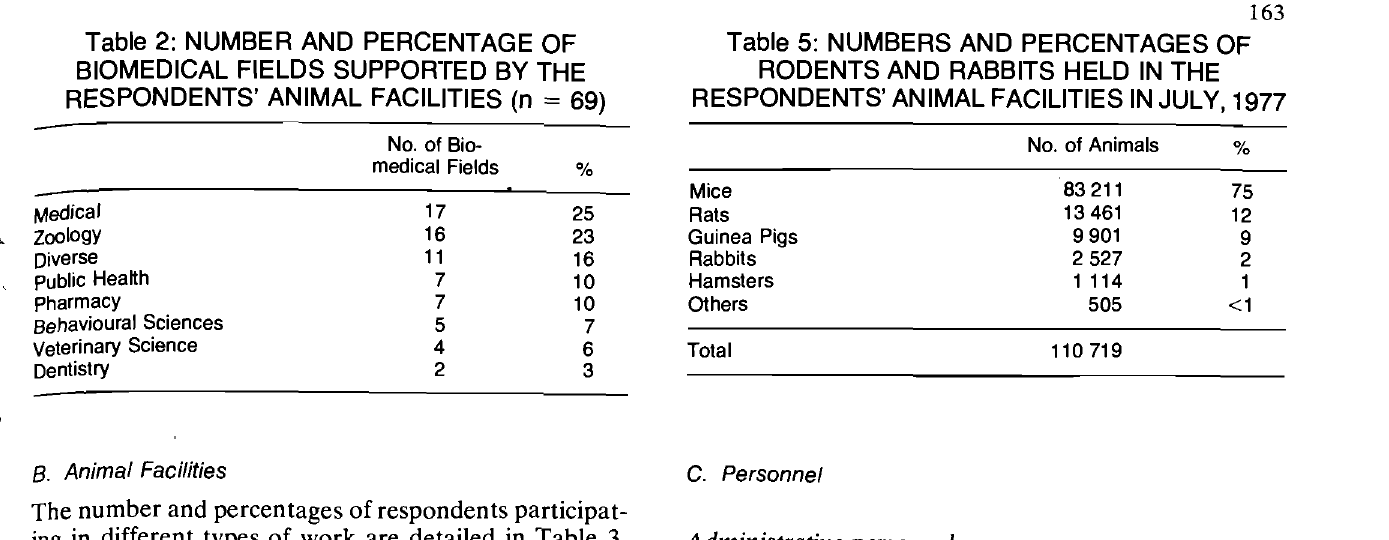
Table 2: NUMBER AND PERCENTAGE OF BIOMEDICAL FIELDS SUPPORTED BY THE